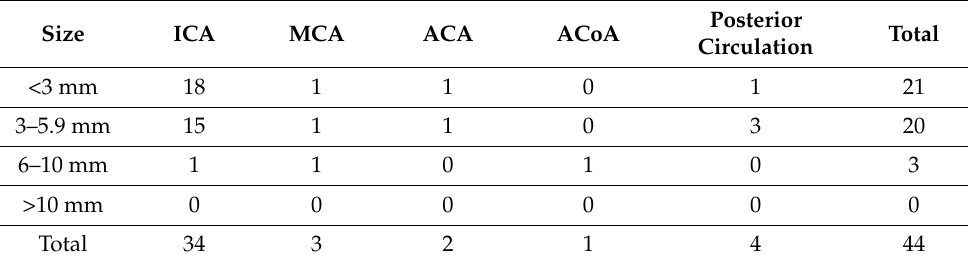
Table 1. Size and location of 44 ICAN in 27 patients with